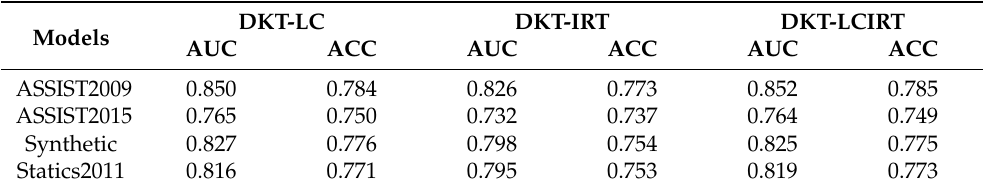
Table 3. Average AUC and ACC values of the three models on all datasets (Learning Capability Features and Item Response